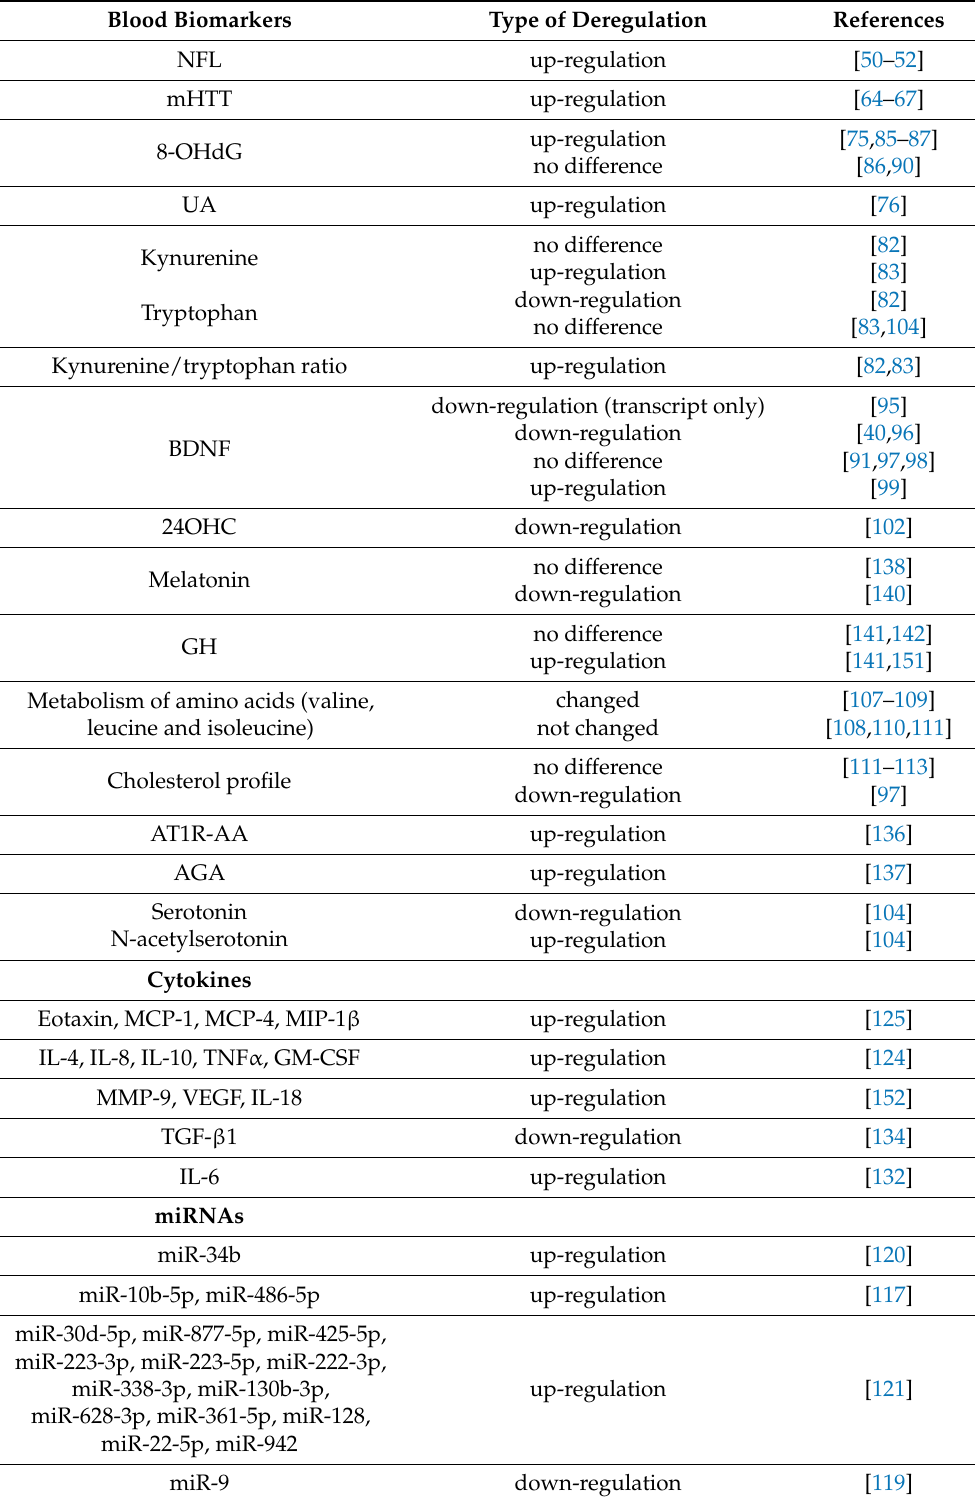
Table 2. Proposed biomarkers found to be dysregulated in periphery of HD